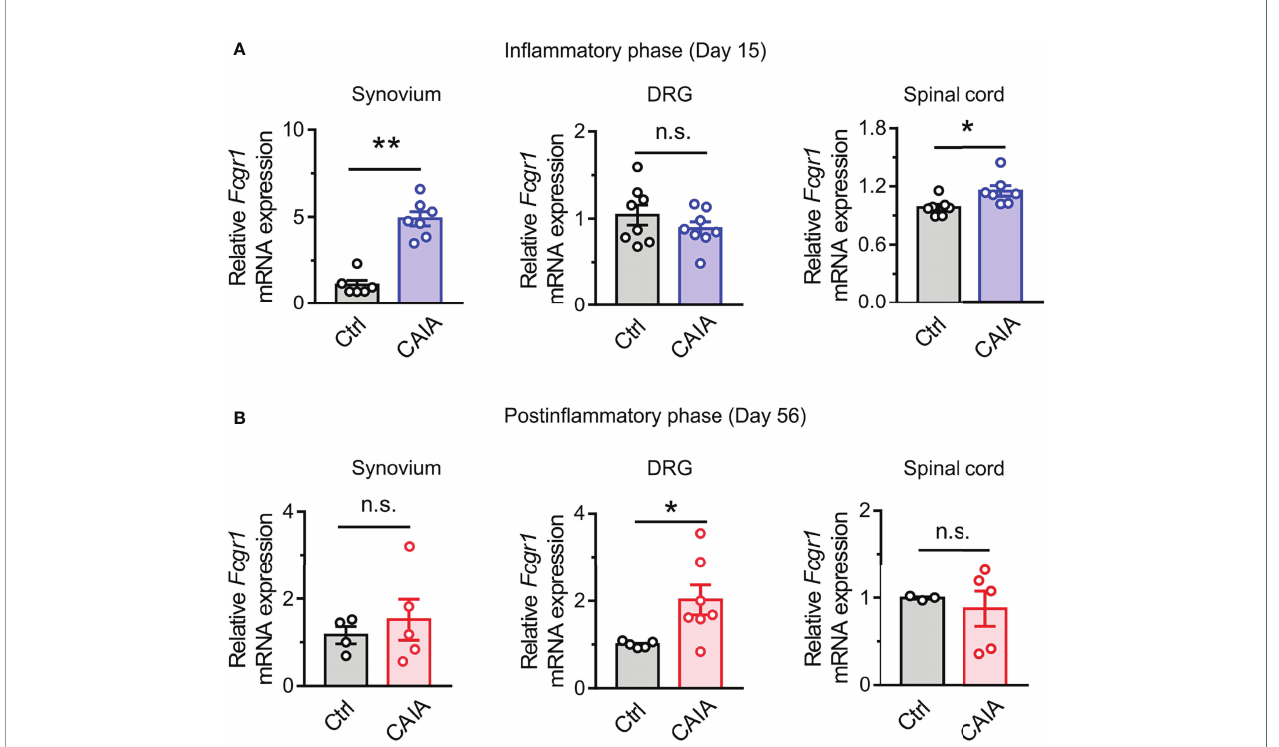
FIGURE 5 | Fcgr1 mRNA expression changes dynamically over the course of CAIA. (A, B) qPCR analysis of Fcgr1 mRNA expression normalized to that of Actb in the DRG, synovium, and spinal cord of control (Ctrl) and CAIA mice on days 15 ( A ; n = 6-8 mice per group) and ( B ; n = 3-7 mice per group) 56 after immunization. *p < 0.05, **p < 0.01 versus Ctrl unpaired Student ’ s t test. n.s., not signi fi